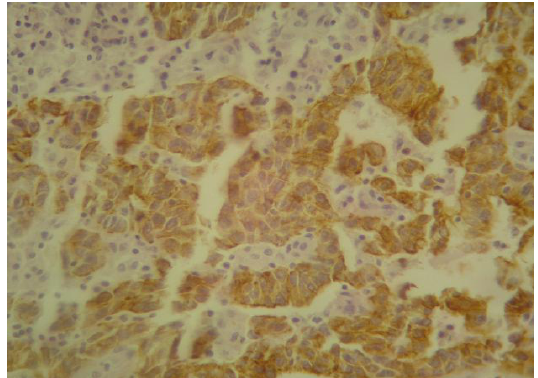
Fig 2. Immunohistochemical staining of